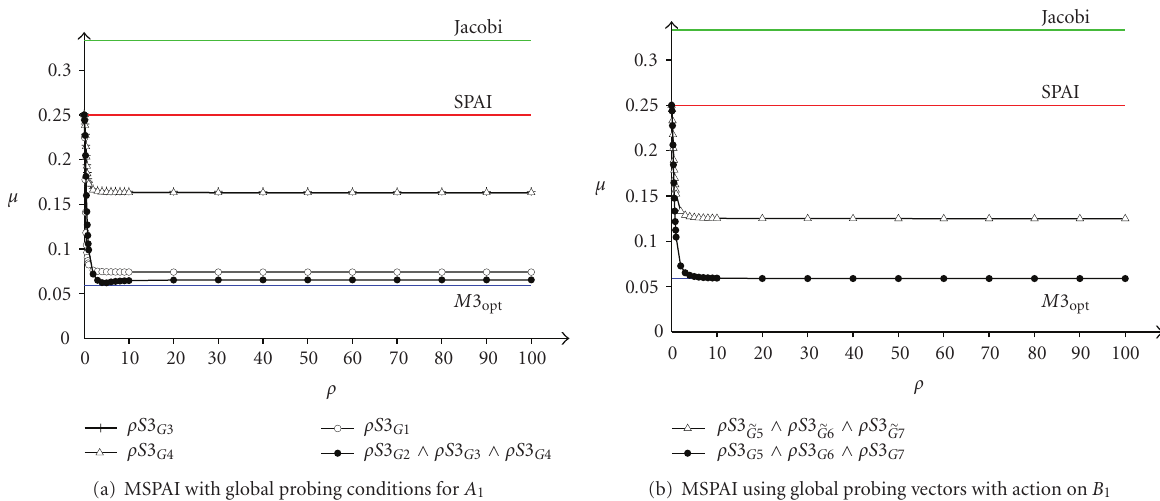
Figure 1: Smoothing factor μ against subspace weight ρ . (a) considers MSPAI using global probing conditions for the constant coe ffi cient system A 1 of size n = 10 3 . (b) shows MSPAI using global probing vectors with action on B 1 with varying coe ffi cients of size n = 10 3 . MSPAI is compared to Jacobi, SPAI, and M 3 opt